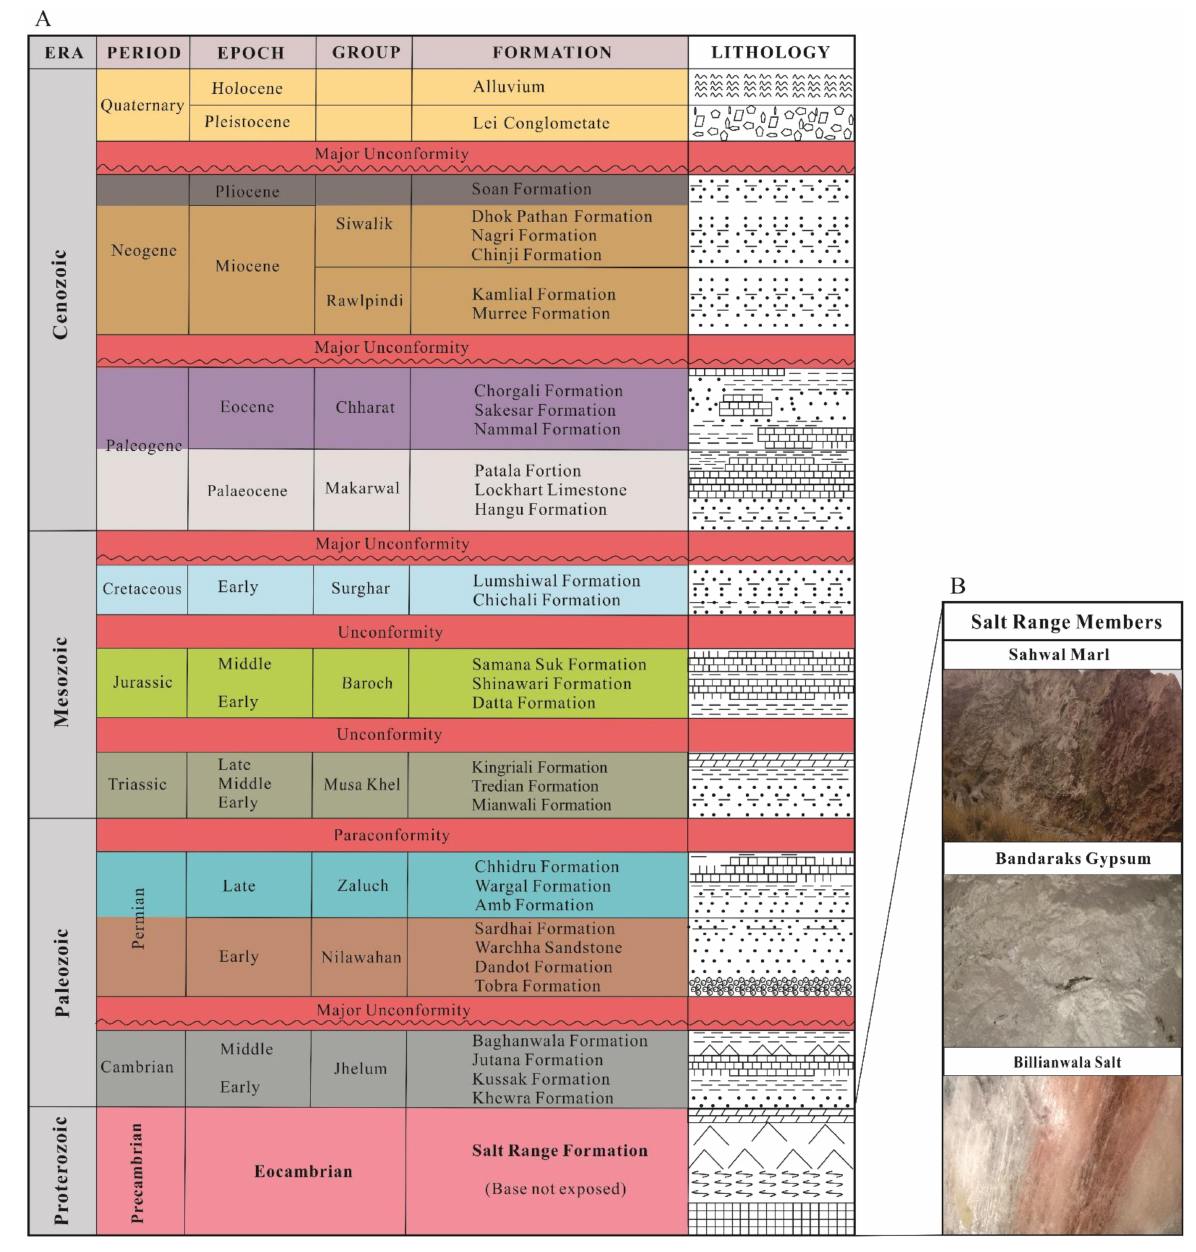
Figure 2. ( A ) Stratigraphic column of the units within the study area. Lithologies of the different formations are also reported (after Grelaud et al., 2002 [31]). ( B ) The Salt Range Member subdivisions (after Sameeni, 2009 [37] and Ghazi et al., 2015